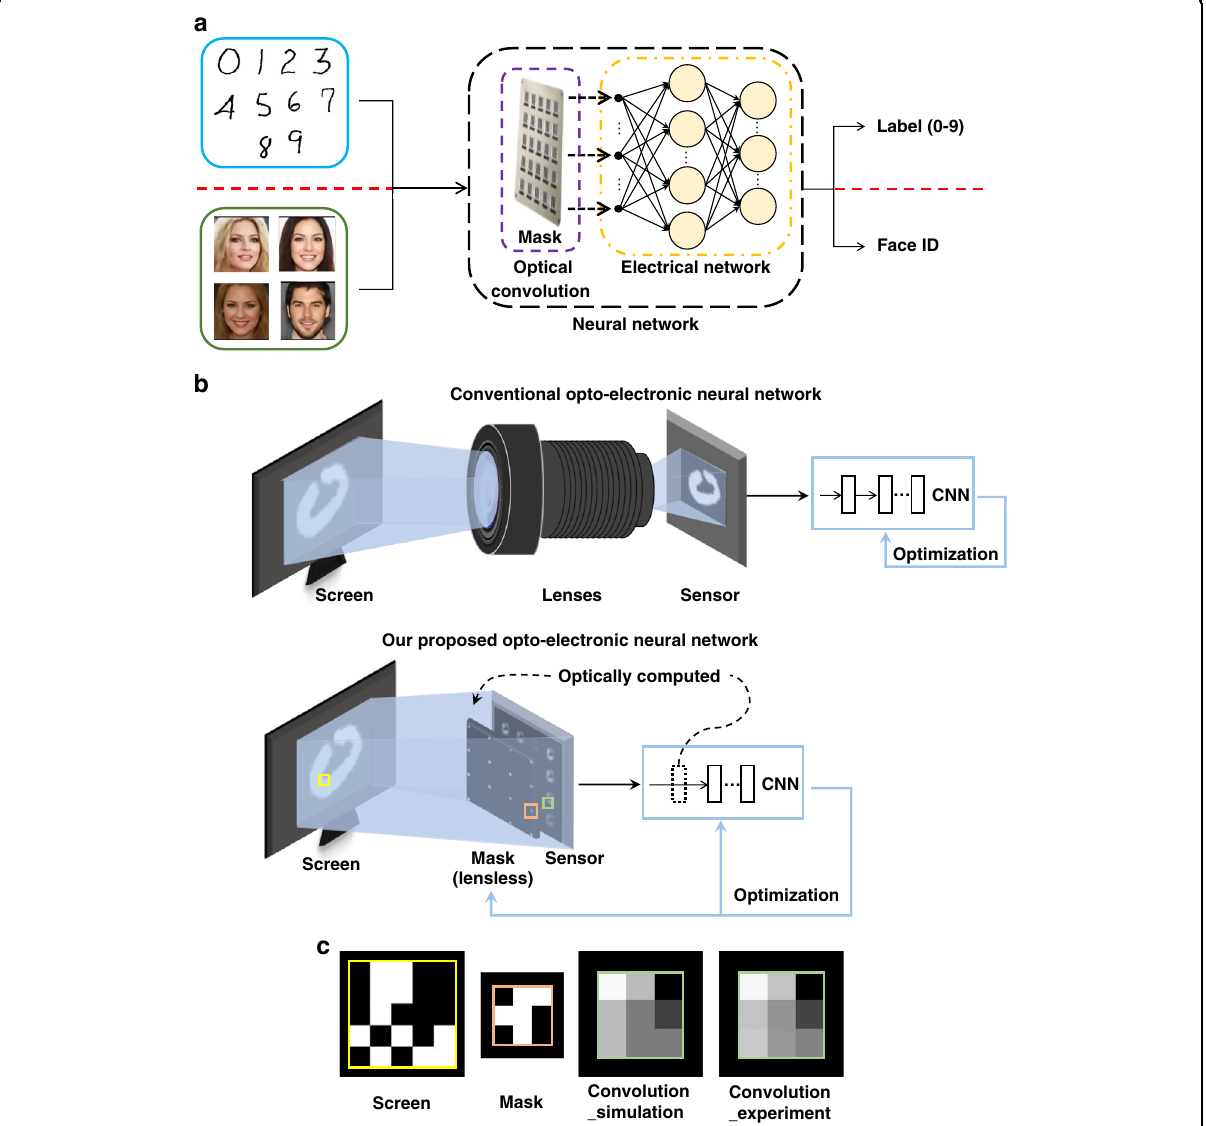
Fig. 1 LOEN: Lensless opto-electronic neural network. a Through machine learning training and joint optimization, LOEN acquires the ability to complete classi fi cation and face recognition tasks. b Comparison of the hardware of the conventional and our proposed LOEN. c Principle and calibration of convolution process by optical mask